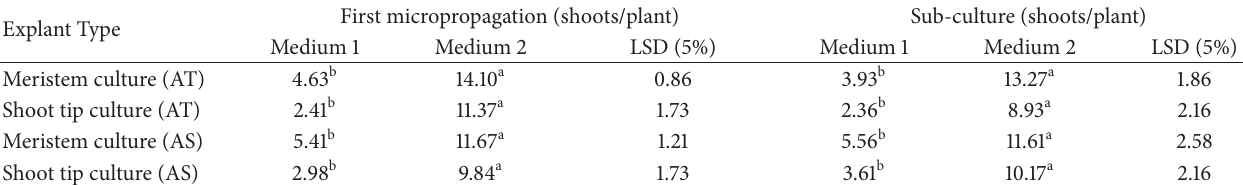
Table 2: Number of shoots/plant obtained from different tissue culture techniques on different garlic species. Explant Type